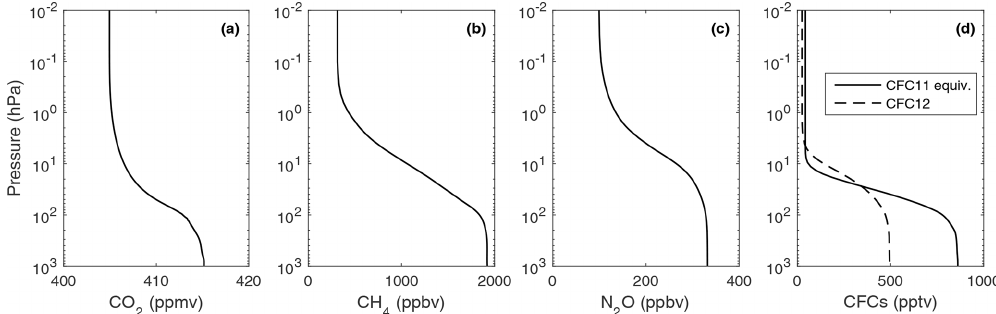
Figure 2. Vertical profiles of the five well-mixed greenhouse gases for the present-day (2020) surface concentrations listed in Table 2.